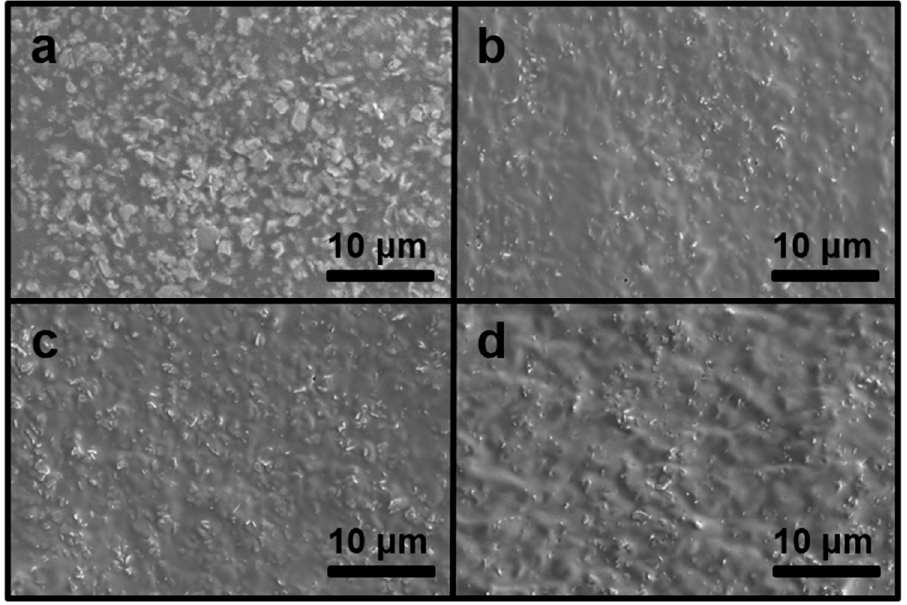
Figure 5. SEM observation of HPMC/MoS 2 /CuO composites: ( a ) HPMC/MoS 2 , ( b ) CuO 1 wt.%, ( c ) CuO 2 wt.%, and ( d ) CuO 3 wt.%.